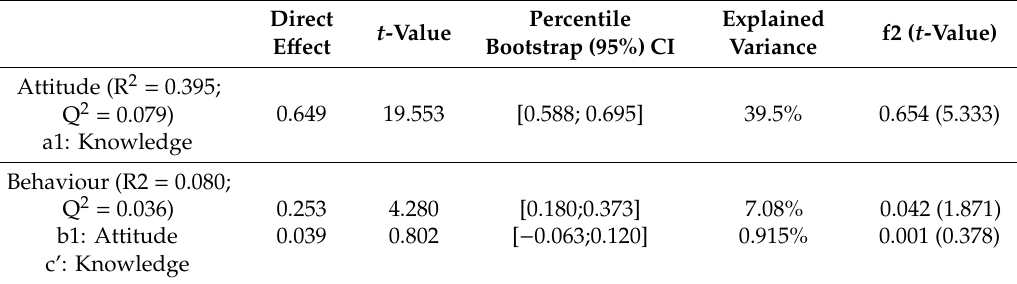
Table 5. E ff ects on endogenous